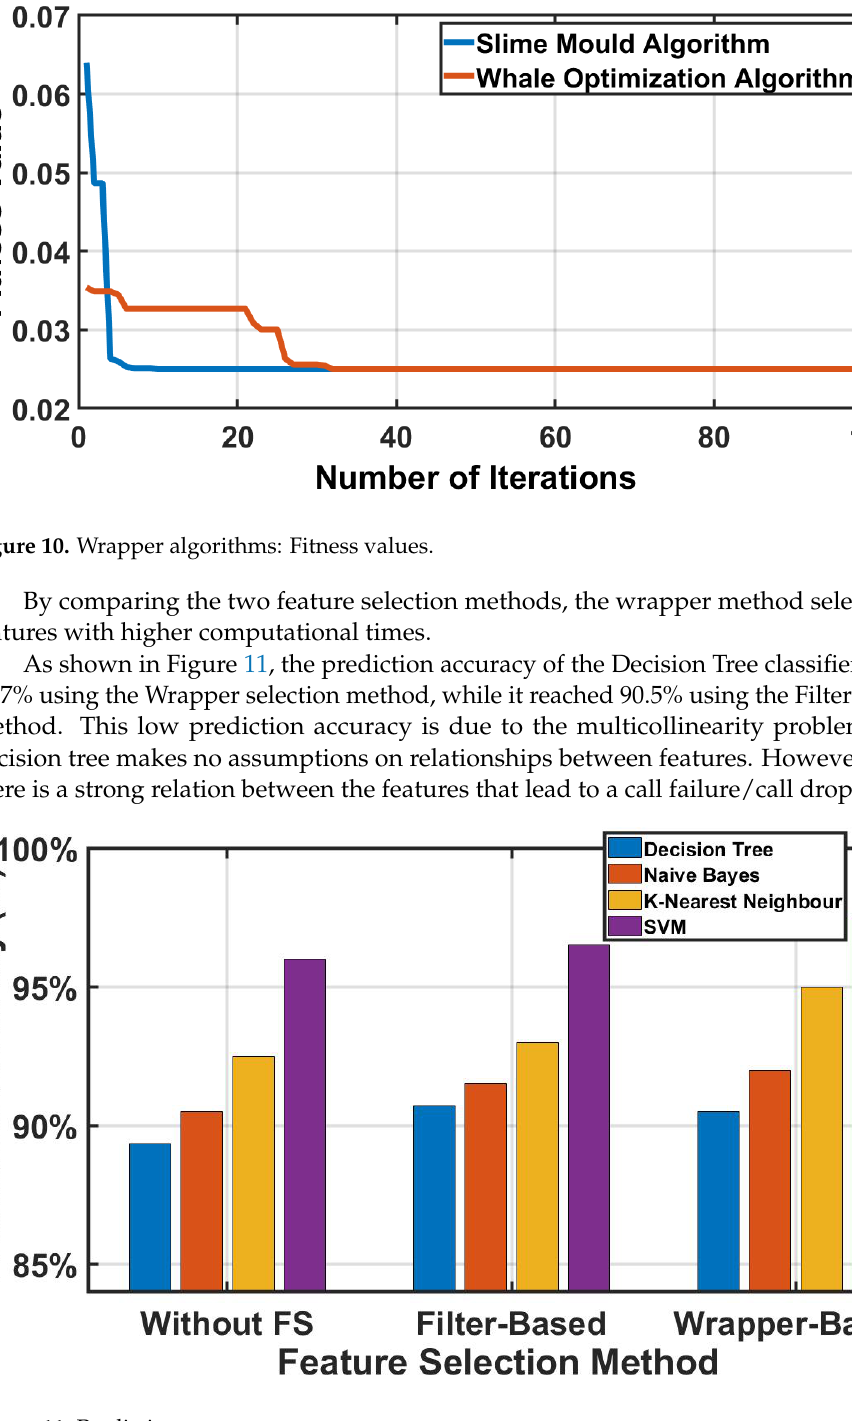
Figure 11. Prediction